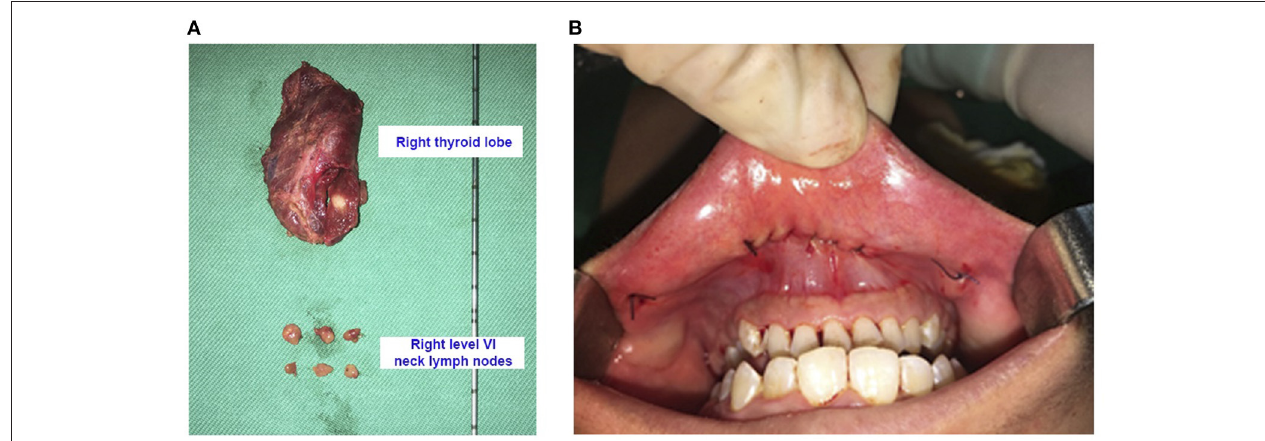
FIGURE 2 | (A) Surgical specimens after right hemithyroidectomy and right central neck dissection (16-year-old female patient with thyroid cancer of the right lobe pT1aN0M0). (B) The incisions were closed by two layers with absorbable interrupted sutures.